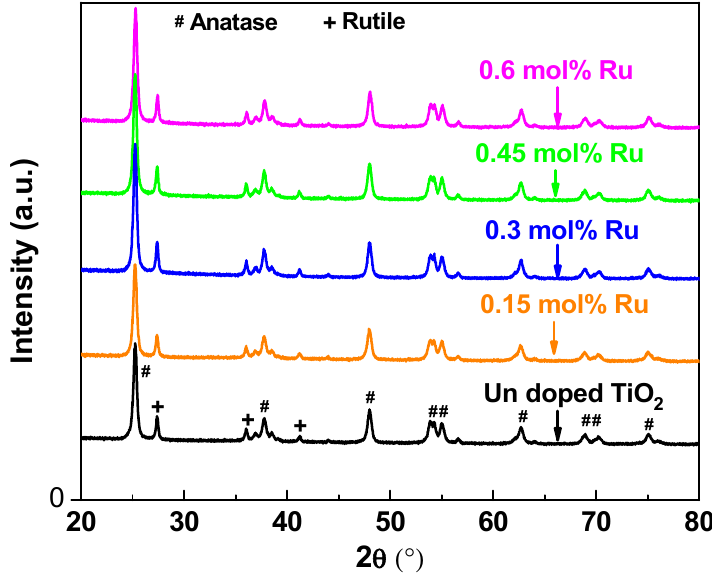
Figure 2. XRD patterns of undoped TiO 2 , 0.15, 0.3, 0.45 and 0.6 mol% Ru-doped TiO 2 nanomaterials.